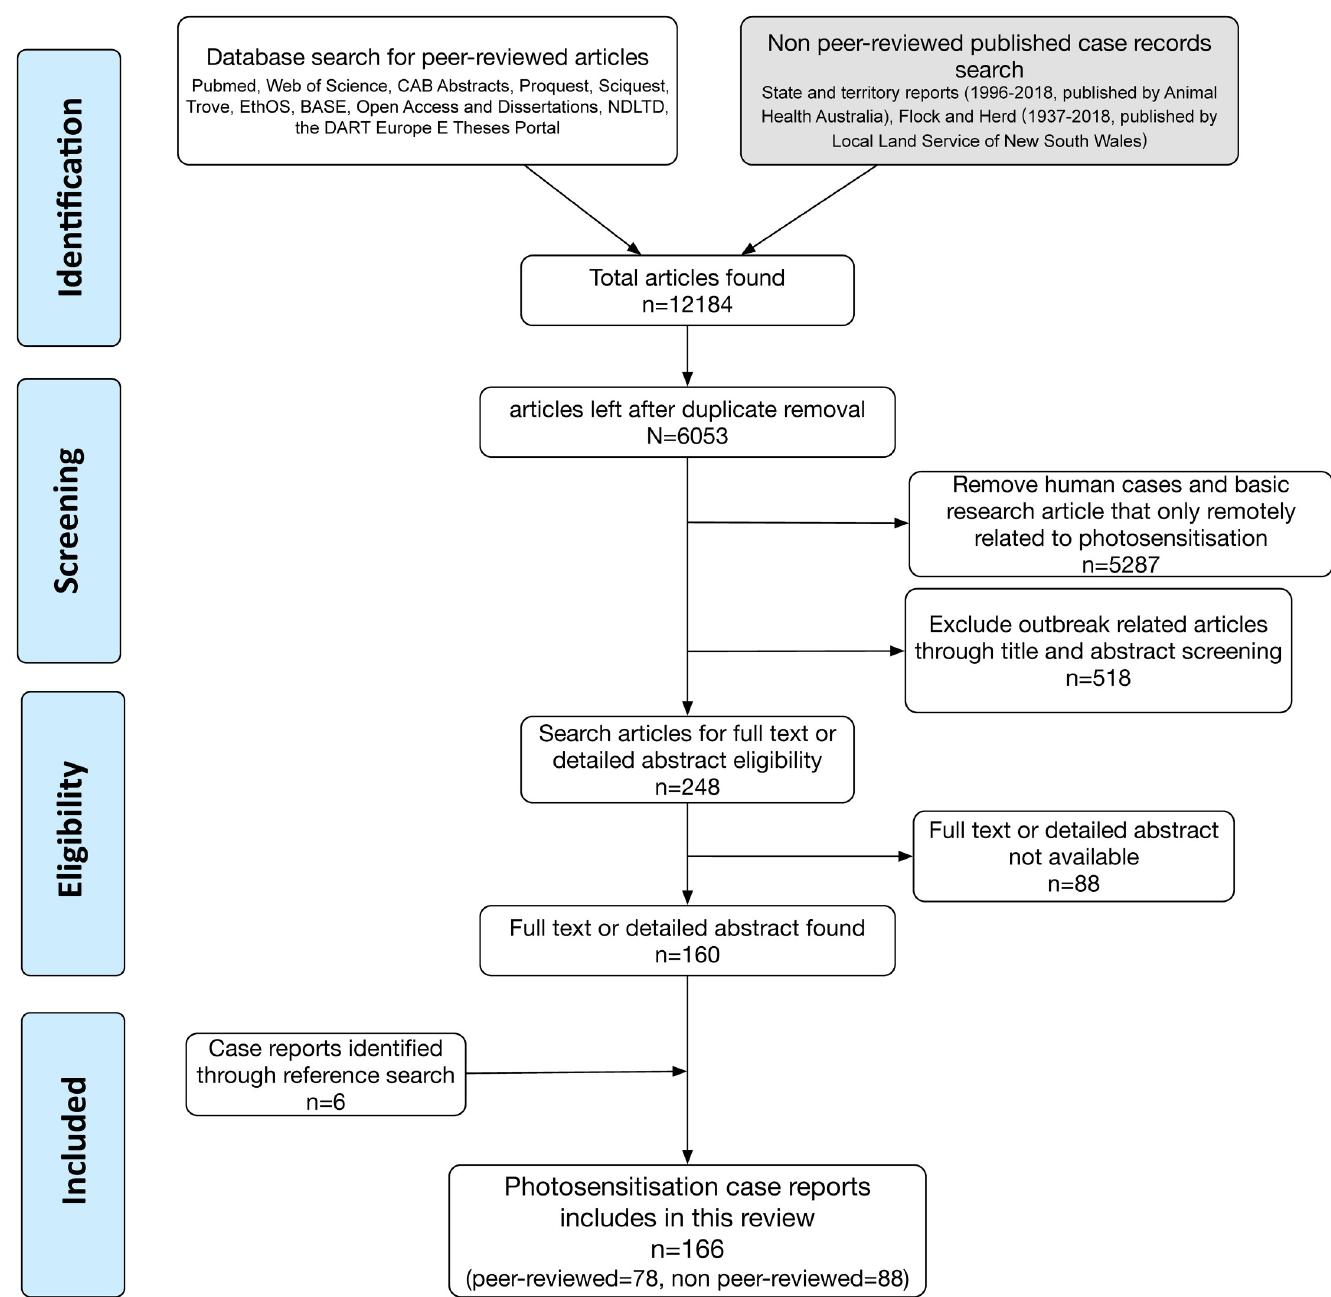
Fig 1. Literature search criteria and the number of articles included and excluded in this